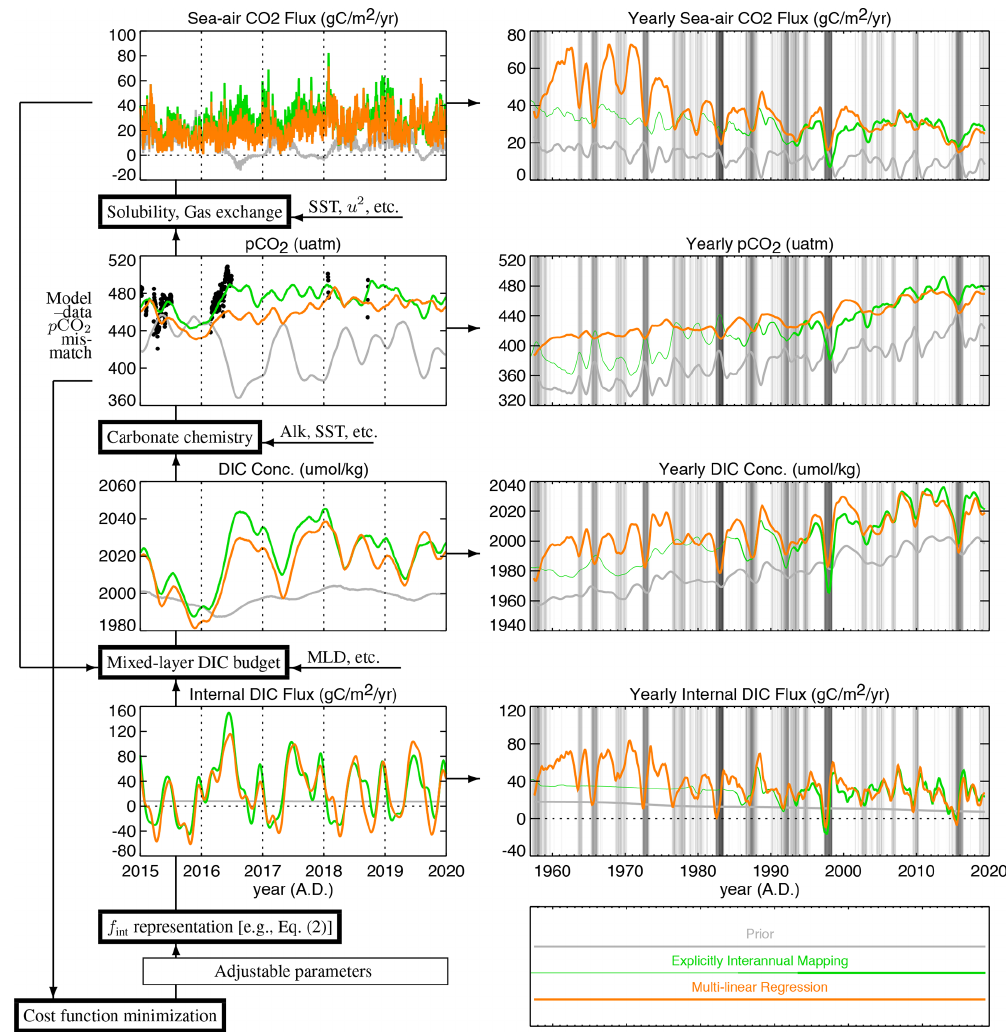
Figure 1. Illustration of the quantities involved in the mixed-layer scheme (time series panels) and the calculations done to connect them (thick-framed boxes). At the arrows on the right of each calculation box, we give its most important environmental input fields (see Table 1). The time series represent the example pixel enclosing the TAO140W mooring location (2 ◦ N, 140 ◦ W) in the tropical Pacific; they are taken from the results of this study but shown here for illustration only. Left: quantities on the original daily time steps, plotted for five example years. Right: the same quantities displayed as smoothed yearly averages, which is the way all results are shown in this paper. The background shading indicates the El Niño–Southern Oscillation (ENSO) phase (multivariate El Niño index (MEI) by Wolter and Timlin,